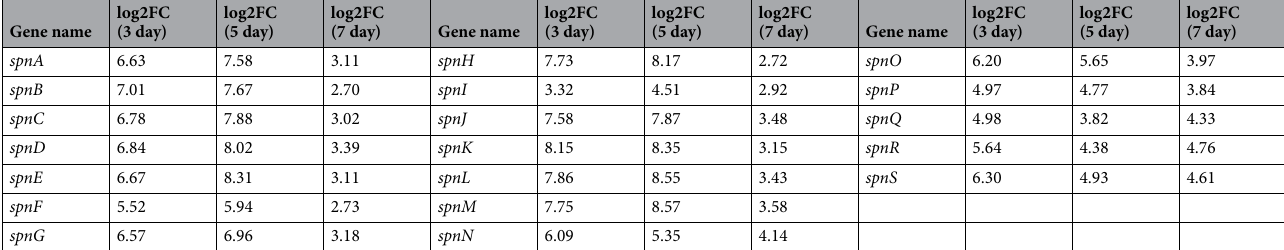
Table 2. The expression levels of genes located in spinosad biosynthetic gene cluster in S. spinosa S3-3 compared to S. spinosa ATCC_49460 at different time